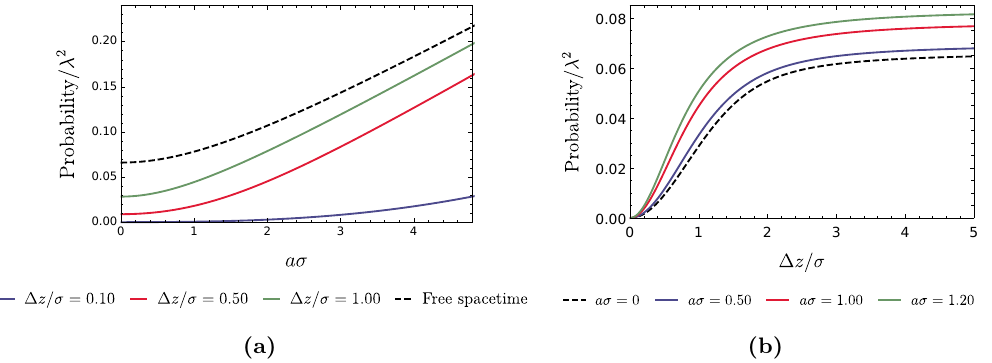
Figure 1. The transition probability of UDW detectors is plotted as a function of the acceleration with parameters Ω σ = 0 . 10 and ∆ z/σ = { 0 . 10 , 0 . 50 , 1 . 00 } in (a), and plotted as a function of ∆ z/σ with Ω σ = 0 . 10 and aσ = { 0 , 0 . 50 , 1 . 00 , 1 . 20 } in (b). For convenience, all other physical parameters are expressed in the unit of the interaction duration parameter σ . Note that the dashed lines indicate the case of without any boundary in (a) and inertial detectors at rest in (b),